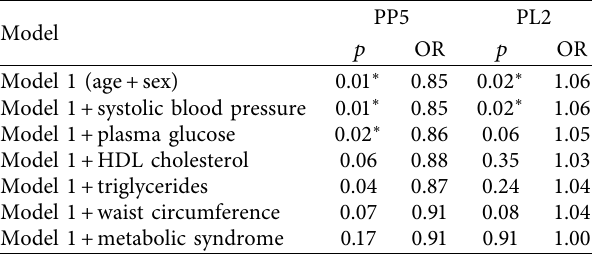
Table 2: Multiple regression model (linear logistic regression) displaying odds ratios which indicate associations between bio- marker principal components and MHO, compared to